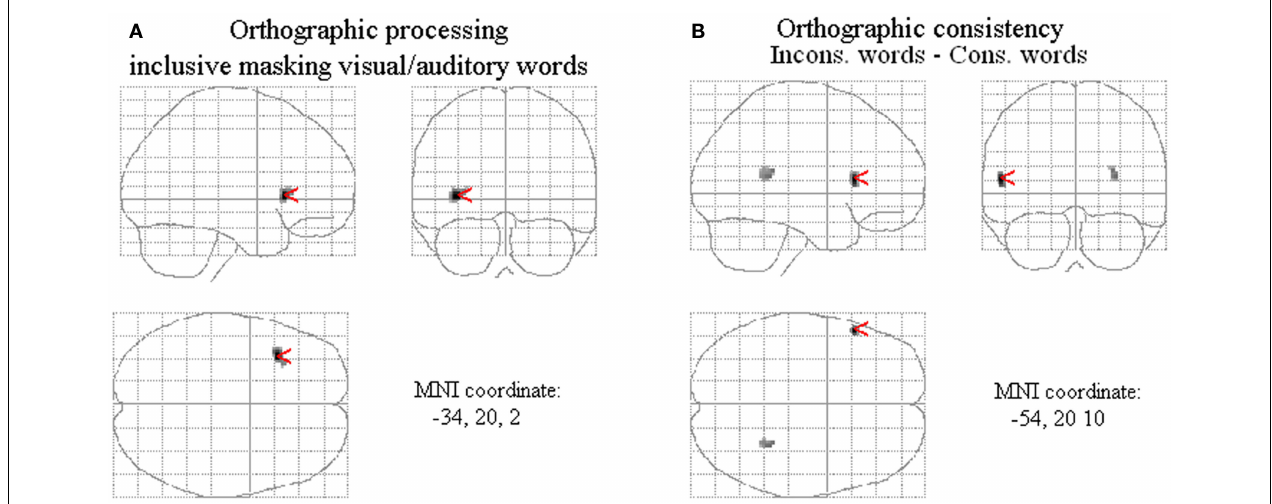
decision–auditory control)], and (B) activation of the left IFG for the consistency effect in the auditory lexical decision task (inconsistent–consistent